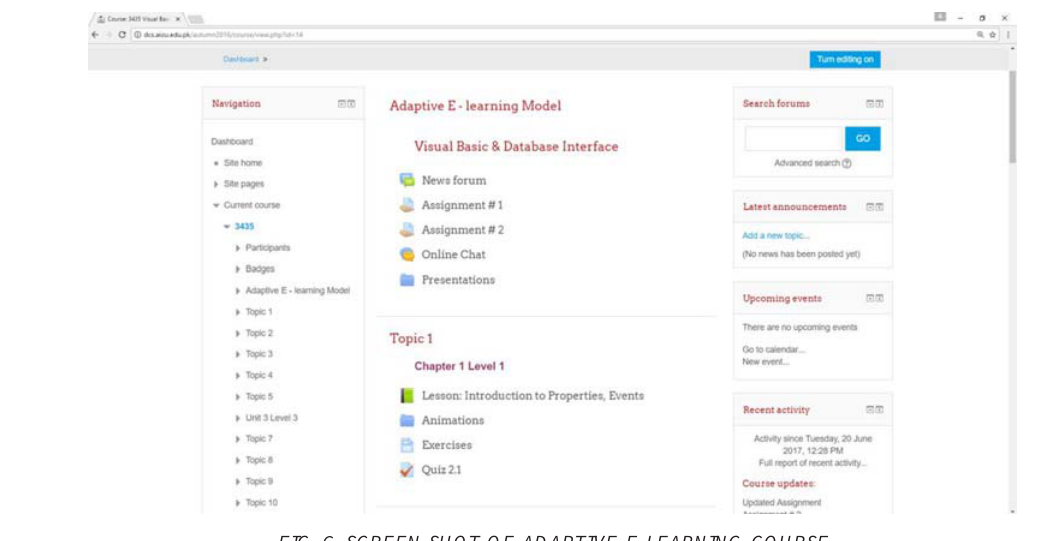
FIG. 5. THREE TIER CLIENT/SERVER ARCHITECTURE OF ADAPTIVE E-LEARNING MODEL